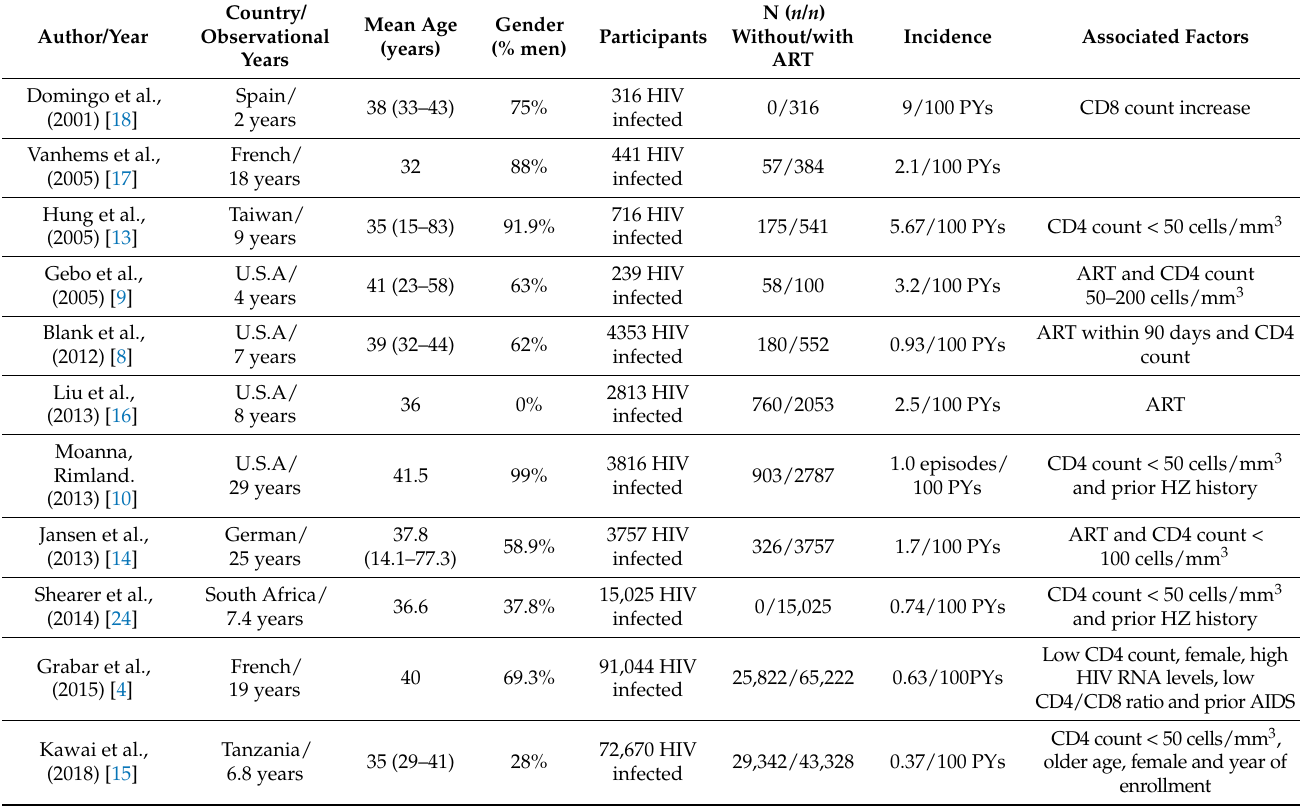
Table 1. Characteristics of studies reporting the incidence rate of HZ among PLWH ( n =